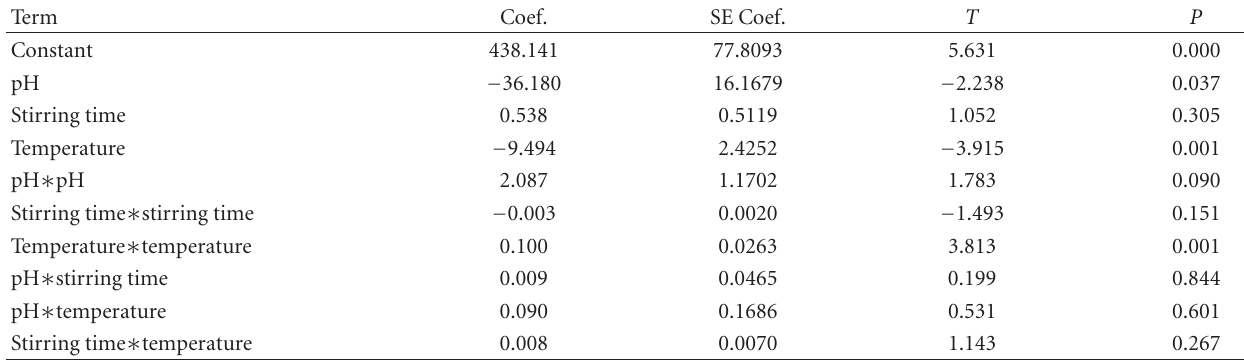
Table 8: Estimated regression coe ffi cients for concentration of leached